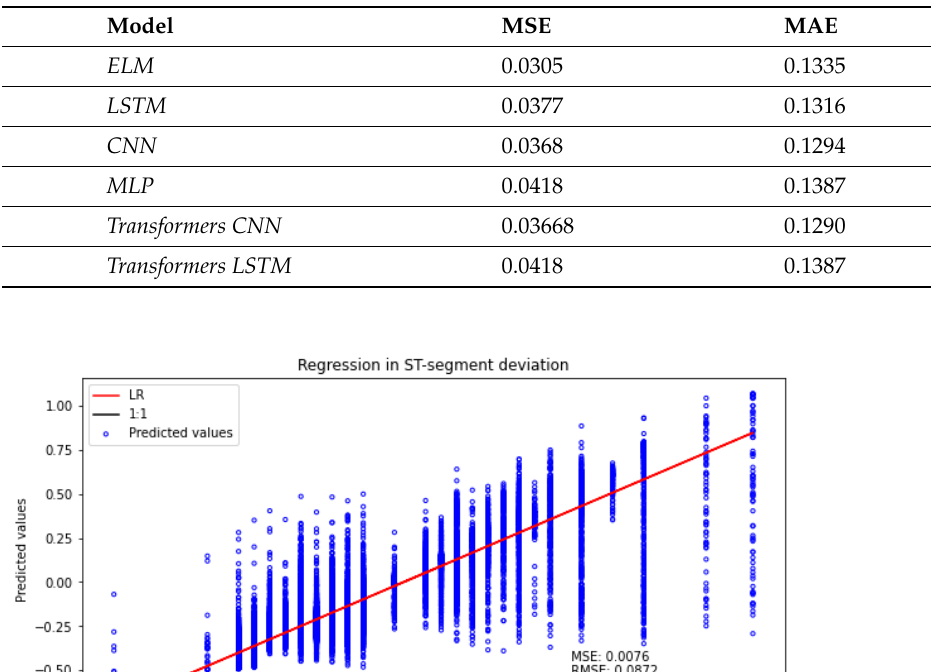
Table 3. Regression models of a different search space for comparison against the proposed analysis.